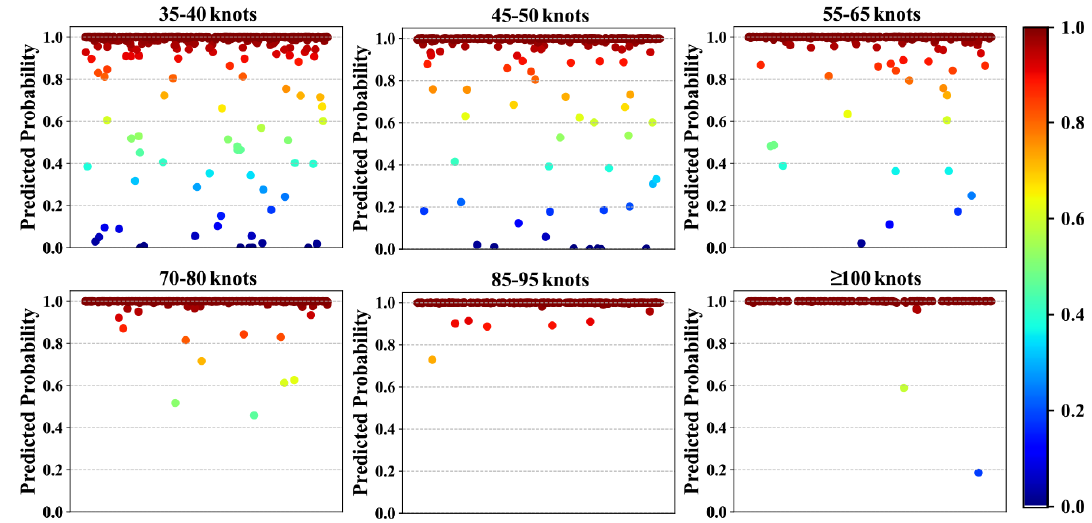
Figure 7. Predicted probability for each of TC images with varied intensity levels in the testing L image dataset via the TG-1